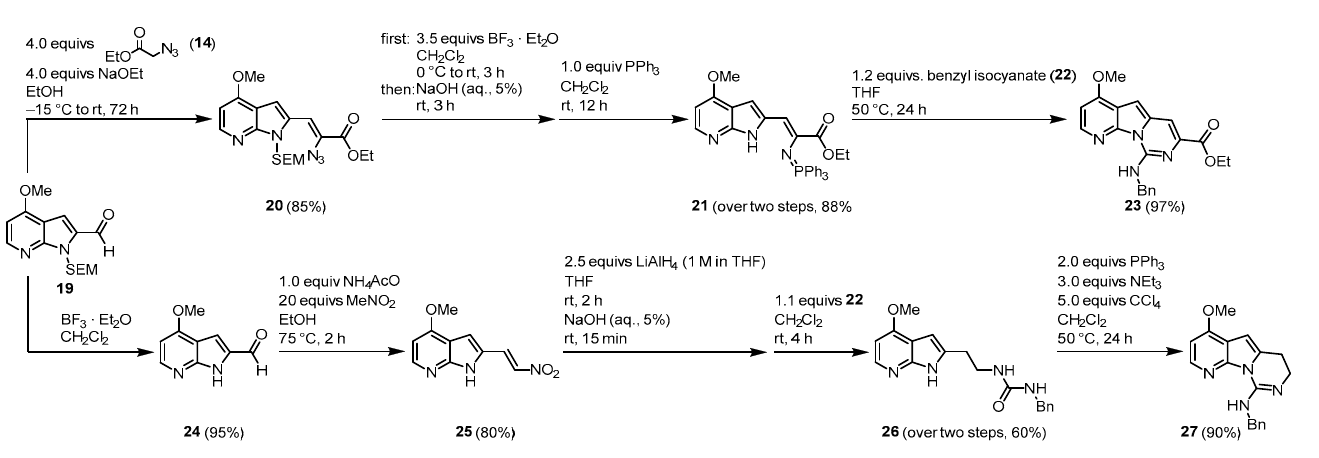
Figure 5. Synthesis of key intermediate azaindole 19 . Reaction conditions for a: first: 1.4 equivs NaH, DMF, rt, 45 min. Then: 1.4 equivs SEM-Cl, rt, 12 h [44].